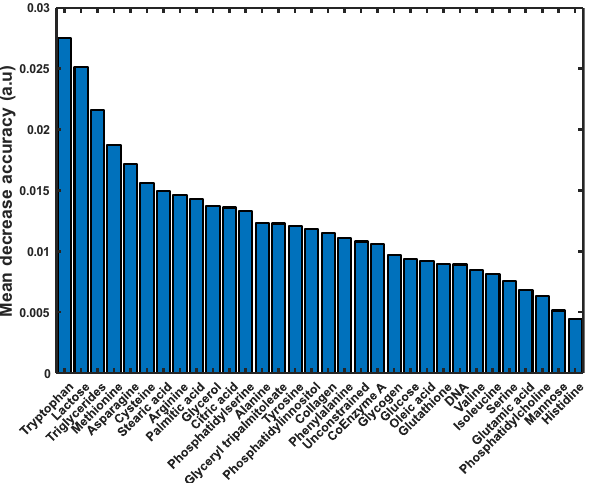
Figure 5. Variable importance plots of the classification of irradiated versus nonirradiated breast tissue Raman spectra based on GBR-NMF scores with Random Forest.